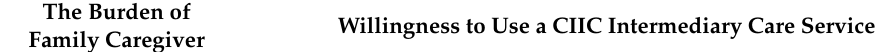
Table 2. The burden of family caregivers, Maehia subdistrict, Chiang Mai, Thailand